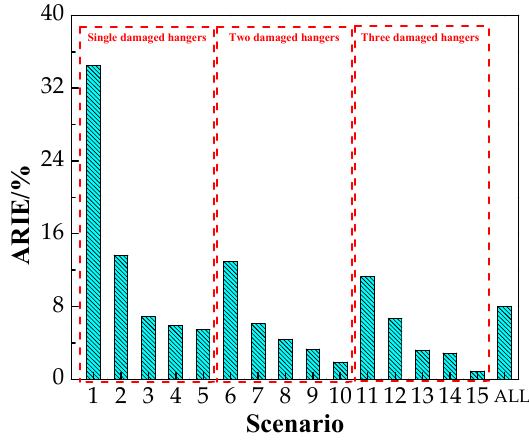
Figure 10. ARIE of CNN-LSTM model about damage severity prediction.